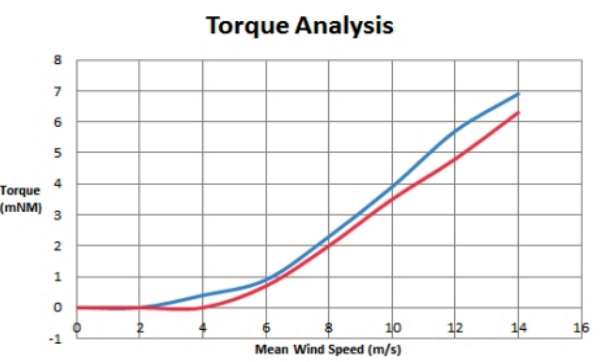
Figure 9. Mean wind speed vs.